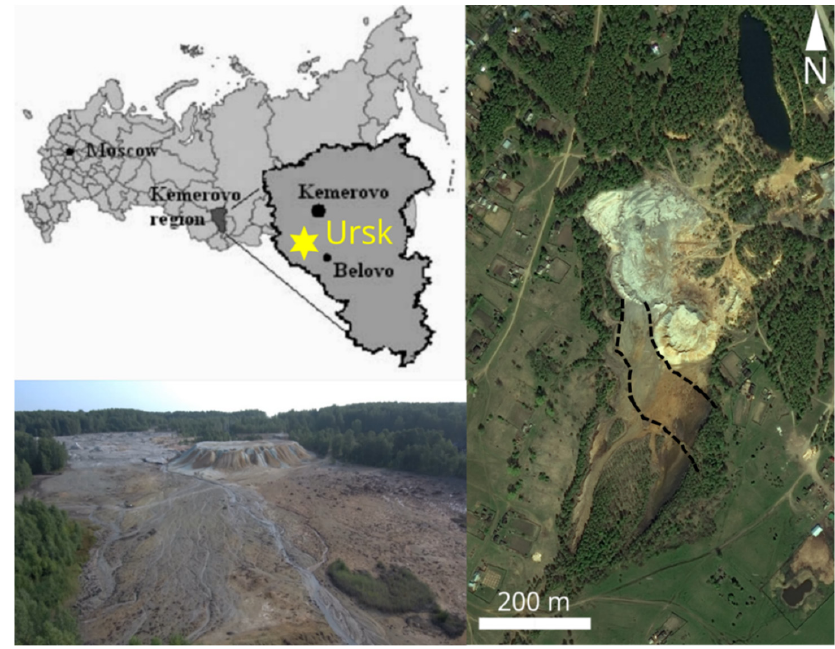
Figure 1. Location of the Ursk dump. The dashed lines indicate the natural fault zone according to [25].